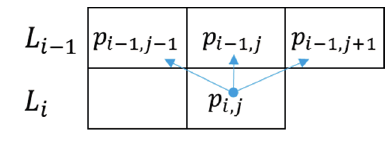
Figure 7. Line grouping.